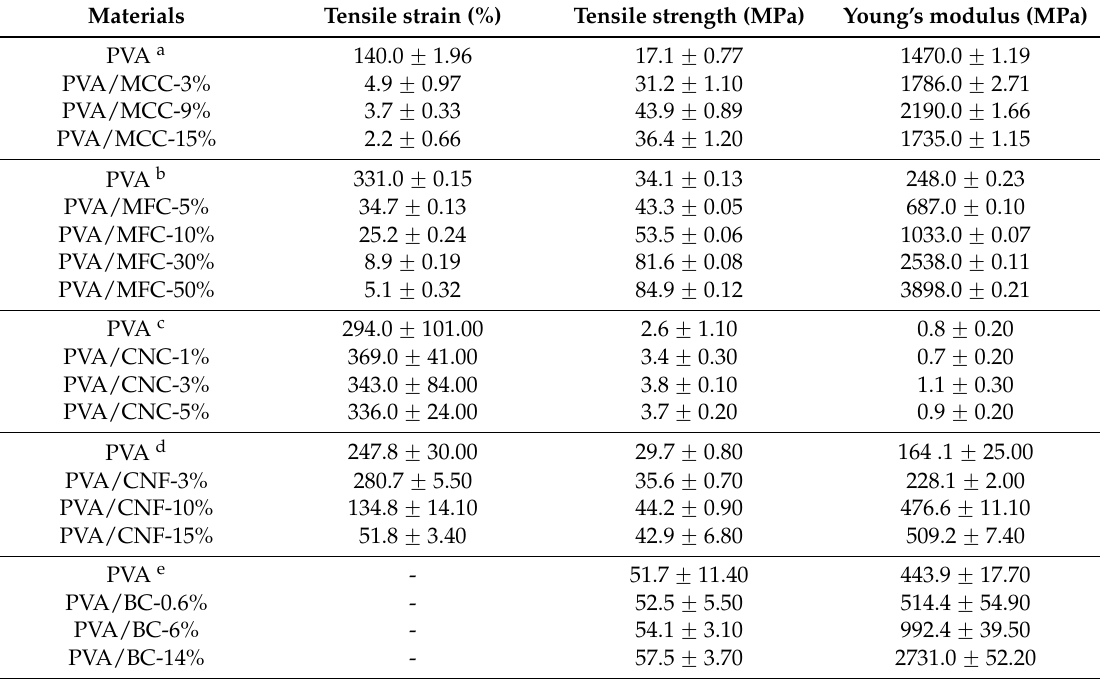
Table 3. Mechanical properties of MCC, MFC, CNC, CNF and BC reinforced PVA [26,29,42–44].